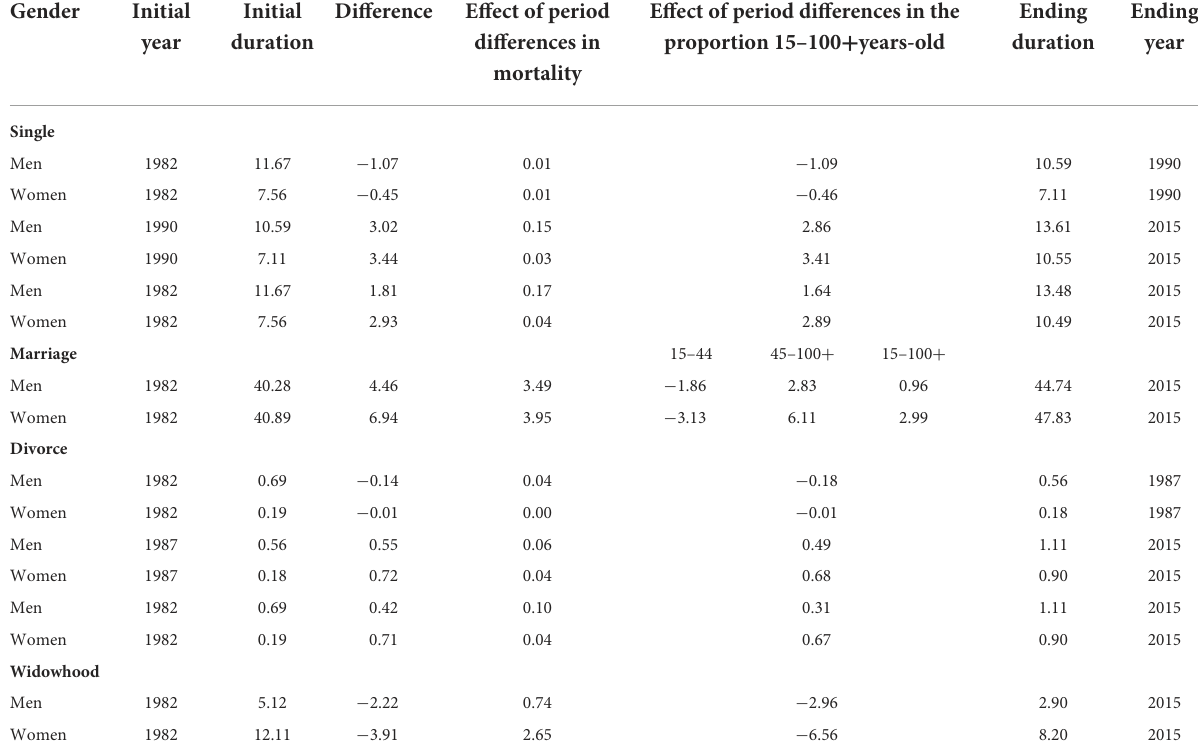
TABLE 2 Decomposition of marital duration period differences among